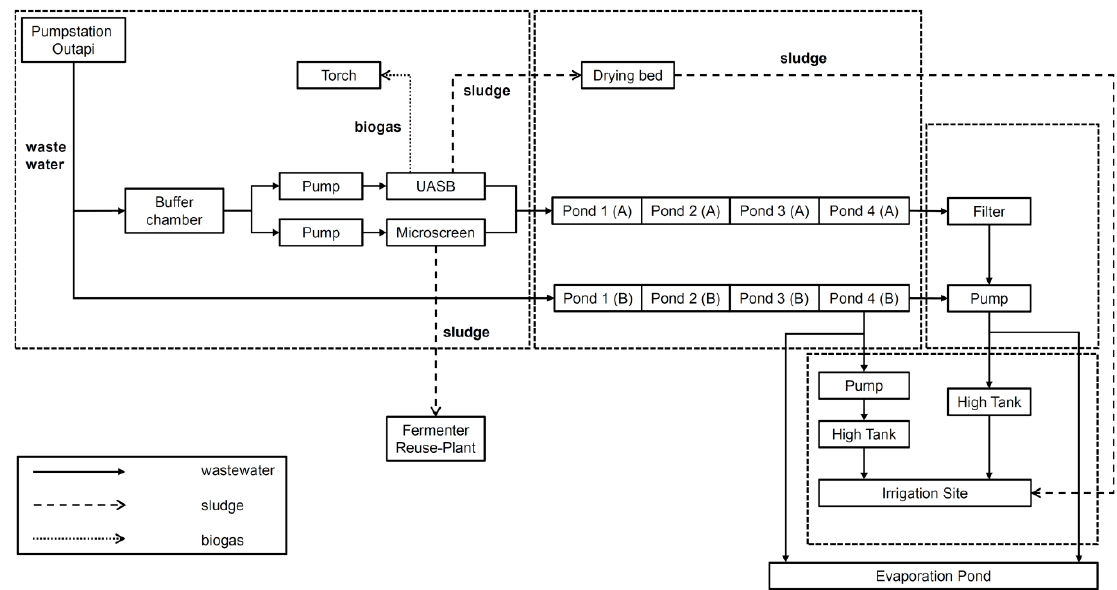
Figure 2. Scheme of upgrading measures (adjusted based on [17]).